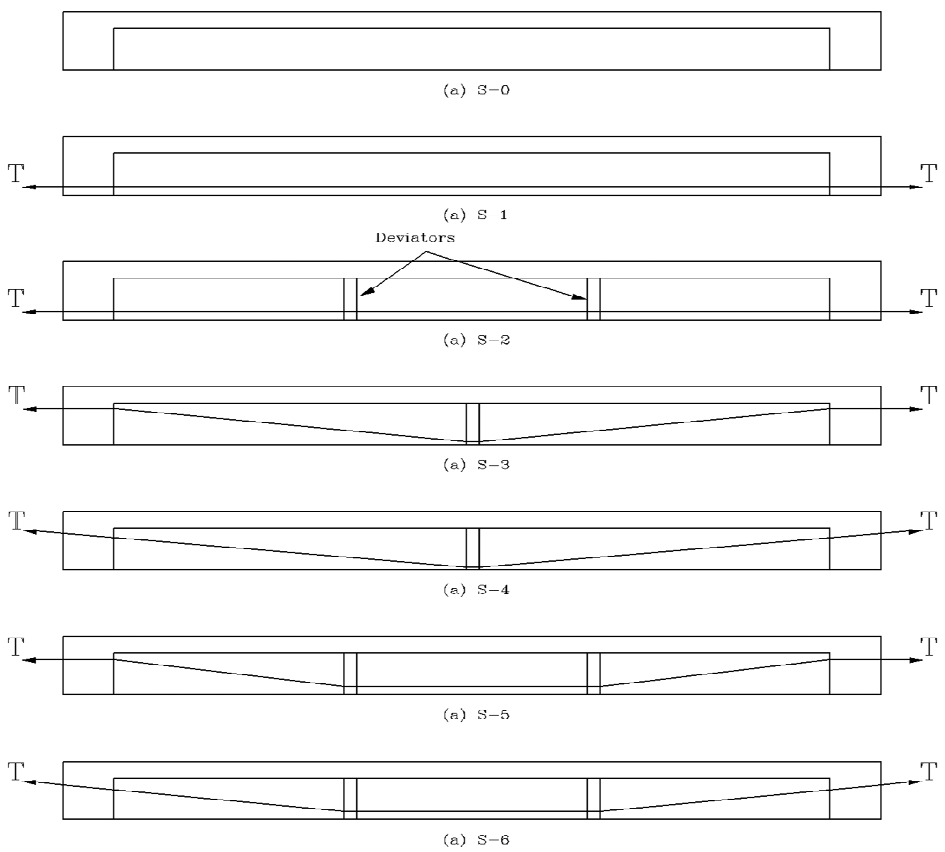
Figure 5. Different methods of external pre-stressing strengthening beams [1].